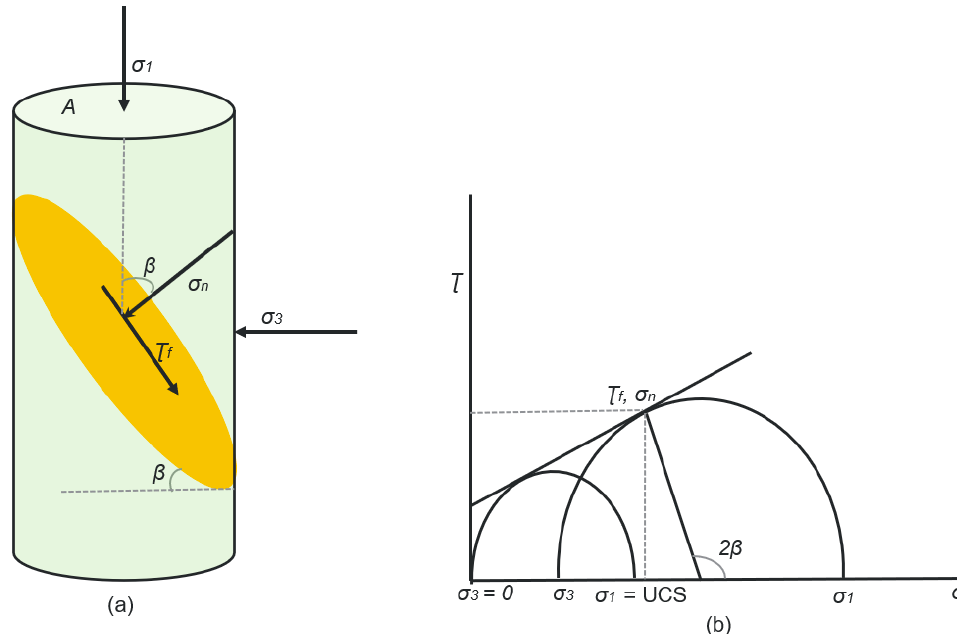
Figure 3. Stresses at failure . ( a ) Illustration of a cylindrical sample (top circle area A ) with a bedding plane at an angle β under a confining pressure σ 3 and maximum compressive stress or axial stress σ 1 . ( b ) The normal stress σ n and shear stress Ʈ f on the plane correspond to the point where the Mohr circle hits the linearized Mohr failure envelope [20] (p. 88).